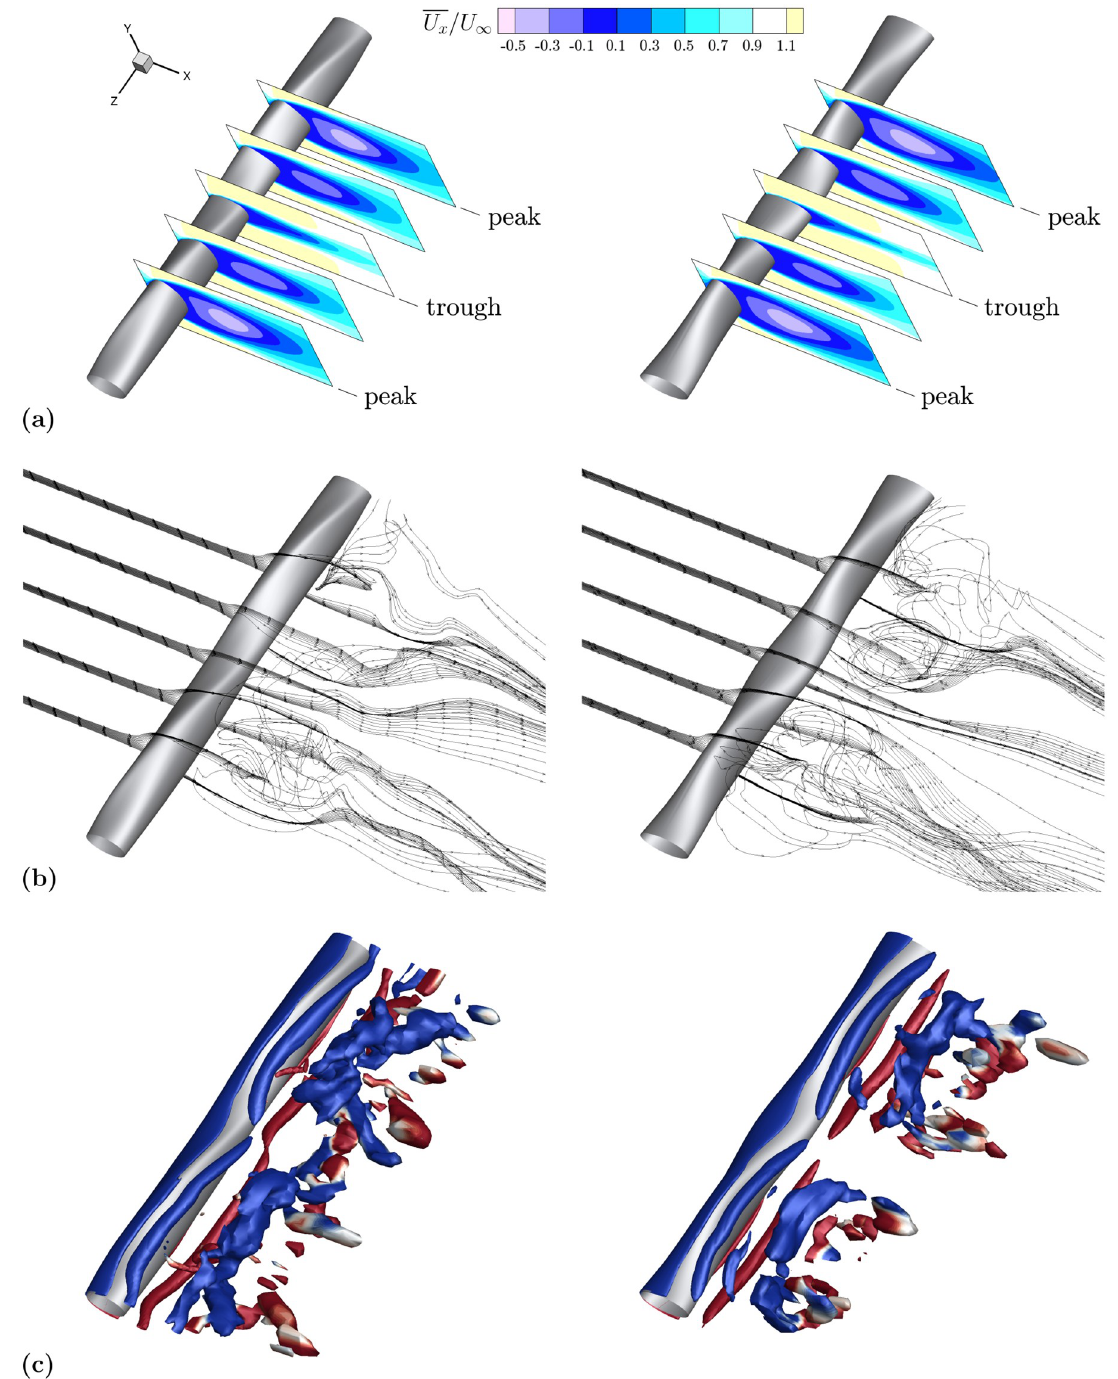
Fig 11. Flow comparison between low and high A The comparison of time-averaged streamwise velocity contours for low A C (left) and high A C (right) models shows a relative similarity between the two models. Contours are shown at equally spaced spanwise locations where peak and trough correspond to A (b) Velocity streamlines at peak and trough spanwise locations denoted in 11a demonstrate the similarity in the streamwise flow component and a modest increase in spanwise flow for the high A colored by positive (red) and negative (blue) z -vorticity. Isosurfaces display a noticeable break towards the center of the high A C model.